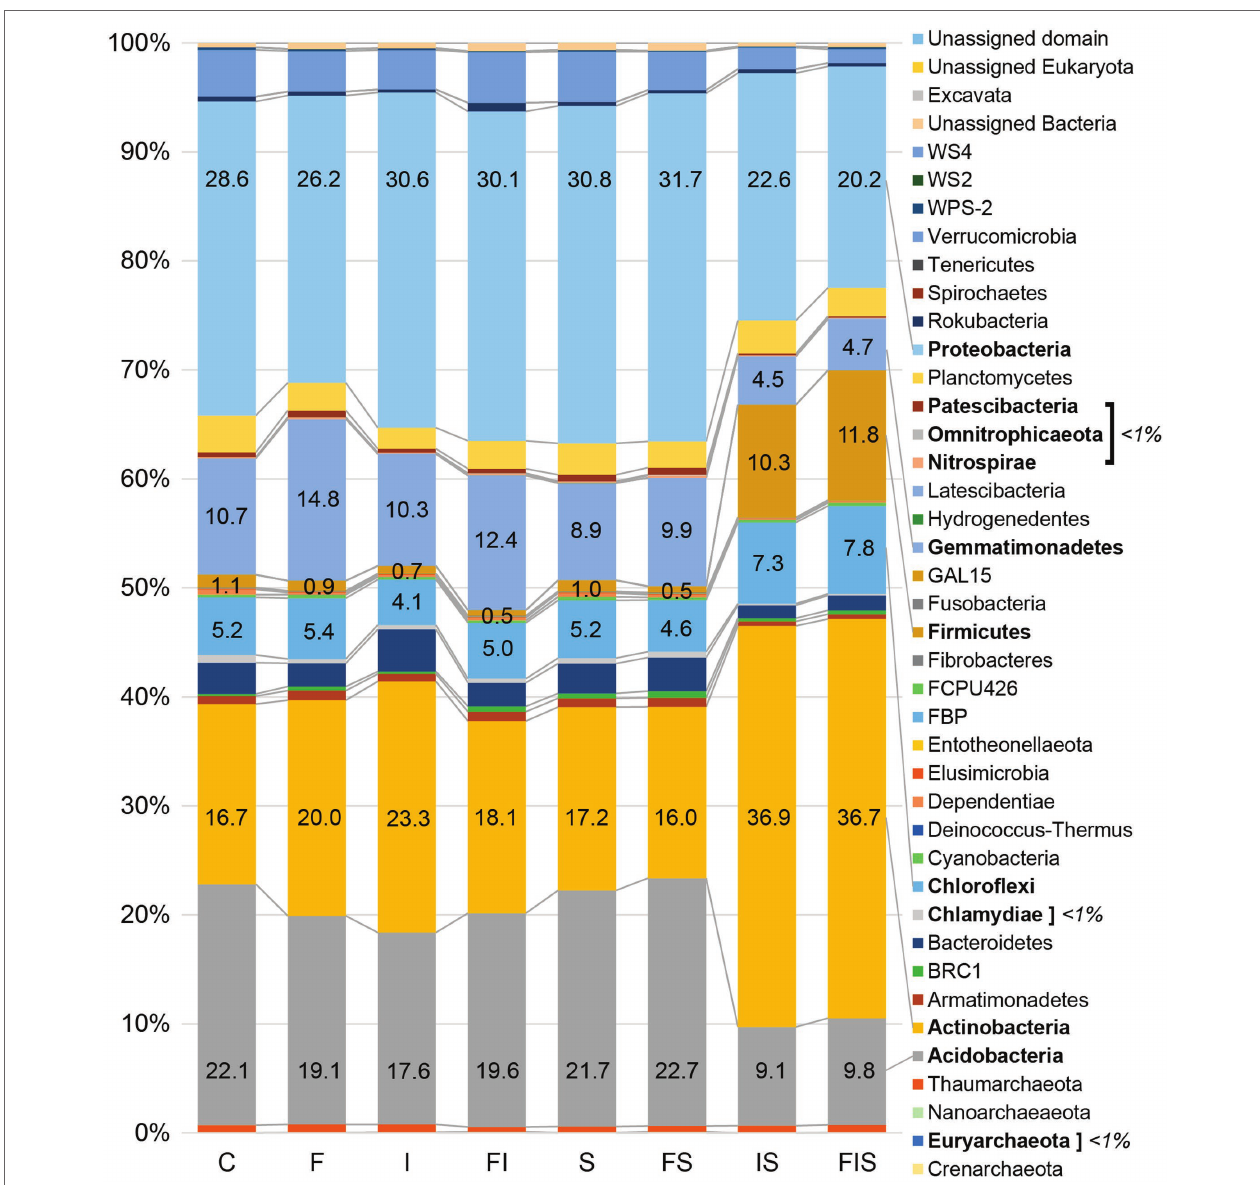
FIGURE 6 | Relative abundances of the microbial communities at the phylum level from the 16S rRNA sequencing from the rhizosphere at V15 ( n = 3). Sequences ( Q > 30) were aligned against Silva 132 99% database using Qiime2 software platform version 2018.8 (https://qiime2.org/). Bars with percentages and names in bold are the most representative and significant phyla ( p < 0.05). Treatments: C, Control; F, Urea-topdressing fertilization at V5; I, A. brasilense inoculant on seeds sowing; FI, F + I; S, Maize stover coverage; FS, F + S; IS, I + S; FIS, F + I +